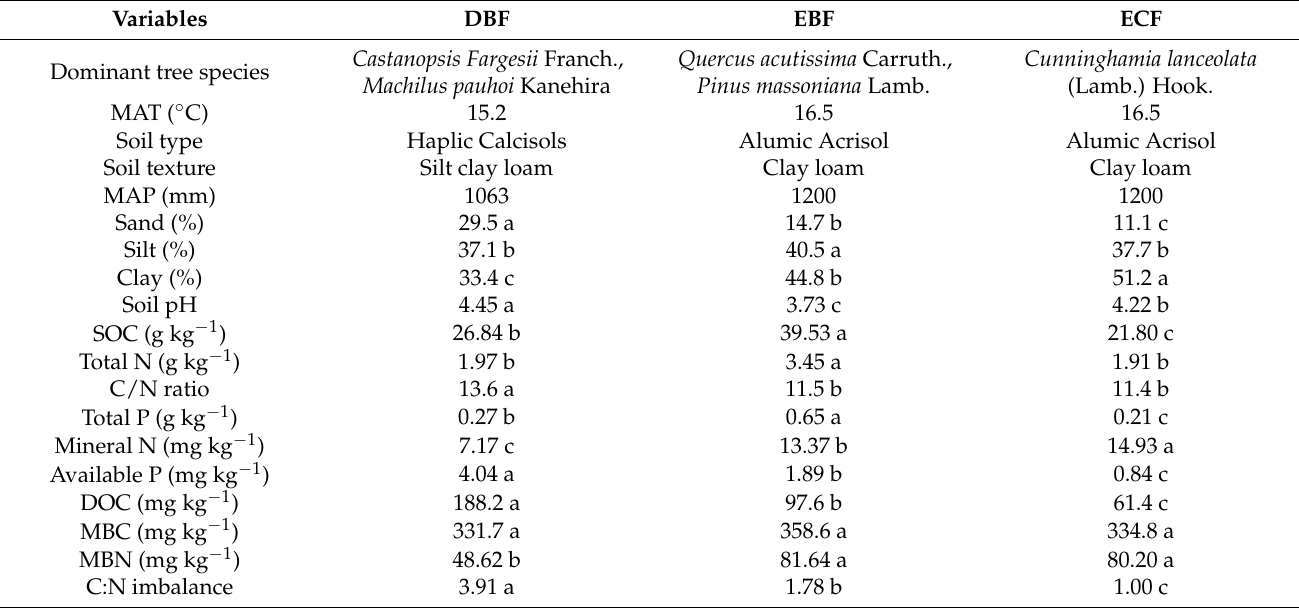
Table 1. Information of the three forests for soil sample